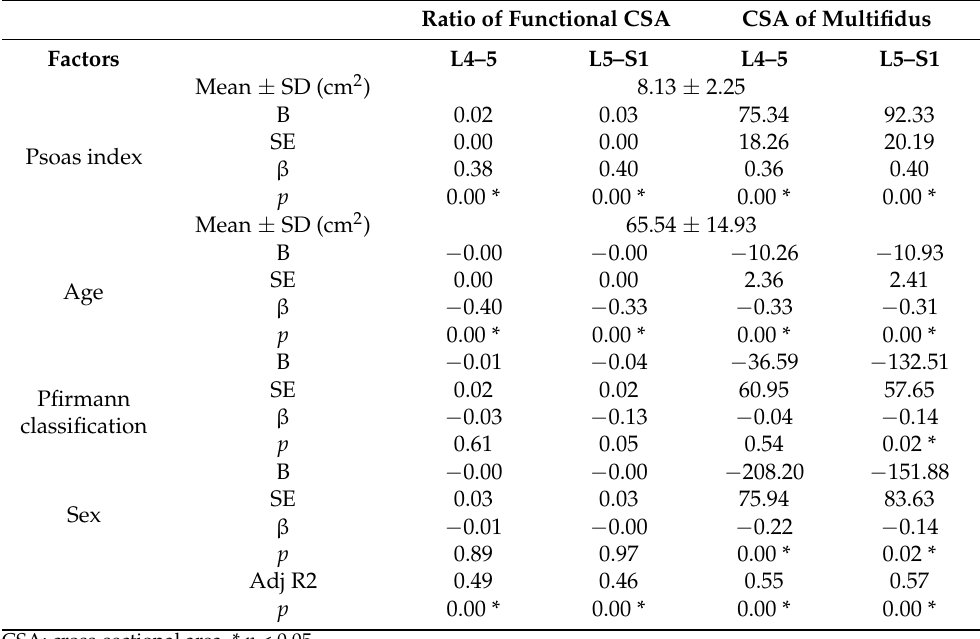
Table 3. Multivariant regression analysis of psoas index, age, Pfirrmann classification, and sex according to the ratio of functional CSA and CSA of multifidus muscle.